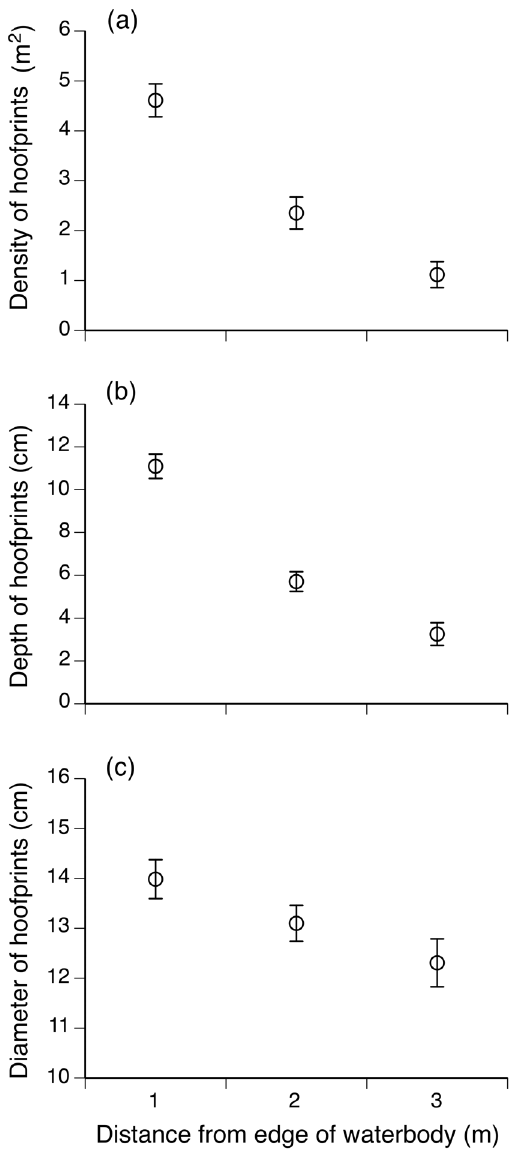
Figure 1. Characteristics of hoofprints made by domestic ungulates (cattle, buffaloes, and horses) at different distances from the edge of three waterbodies in tropical Australia. The panels show means 6 1 SE of density (a), depth (b), and diameter (c) of the hoofprints that we measured.